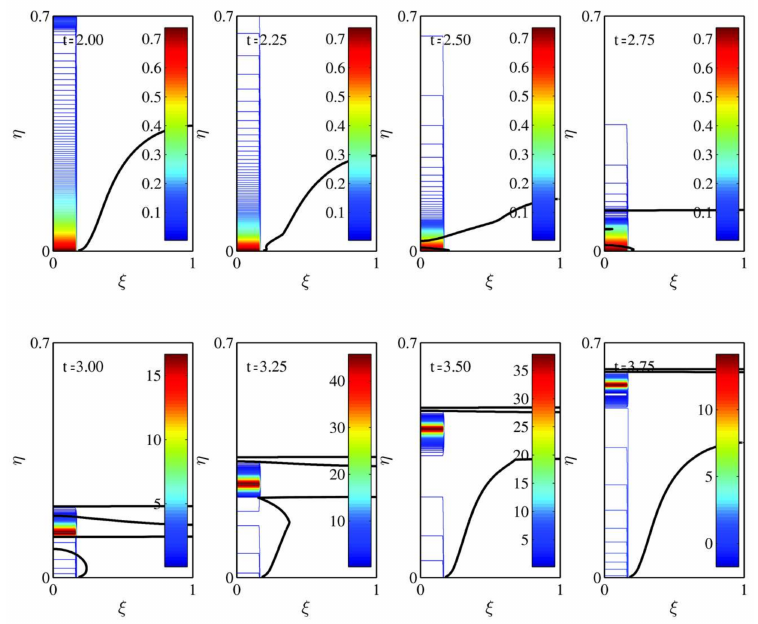
Figure 6. Evolution of normalized mass fraction of liquid fuel—with droplet grouping; the solid black lines represent the flame